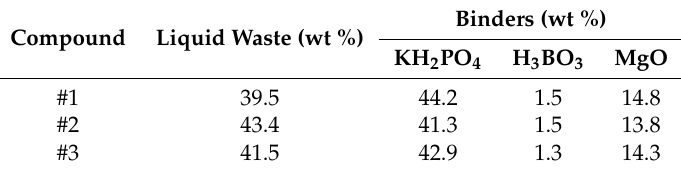
Table 2. Composition of magnesium potassium phosphate (MKP) compounds under